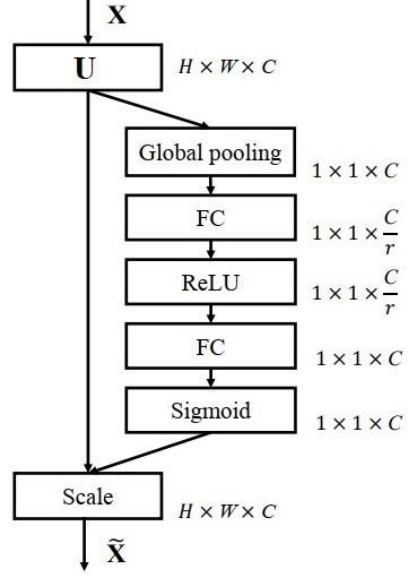
Figure 3. The SENet algorithm process.